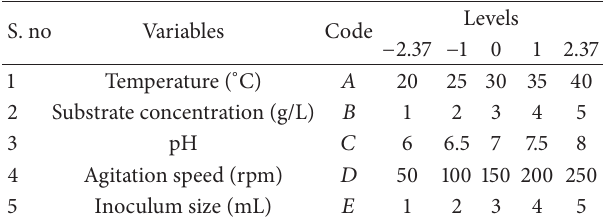
Table 5: Ranges of variables used in CCD.